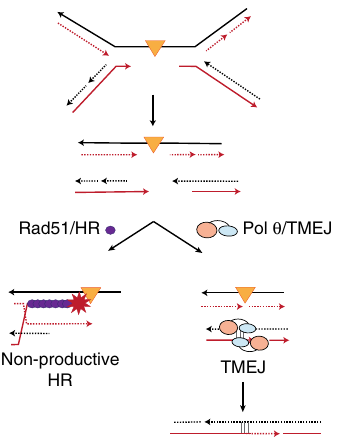
Fig. 7 Model for TMEJ in suppressing non-productive HR at replication- associated DNA damage. Orange triangle indicates a replication- obstructing lesion, such as ICL, G4, or base damage, with an associated region of under-replicated DNA. Converging replication forks will generate a two-ended DSB that can undergo end resection to expose 3 ′ overhangs. Rad51 loading and attempted HR may result in unsuccessful repair due to persistence of the replication blocking lesion in the homologous template DNA. Alternatively, TMEJ is able to perform microhomology-mediated end joining of the exposed 3 ′ overhangs, without requiring a homologous